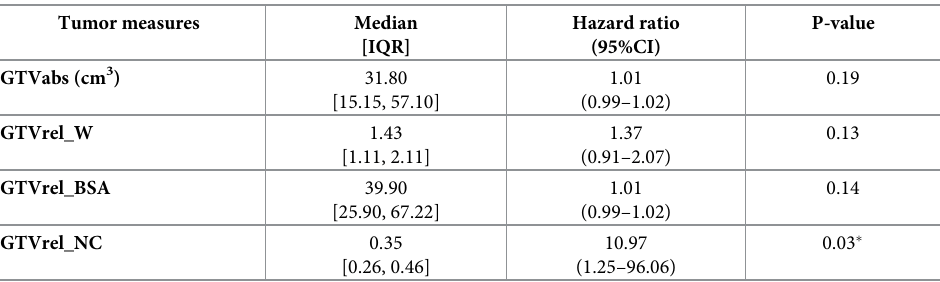
Table 2. Impact of different tumor measures on TTP. Tumor measures